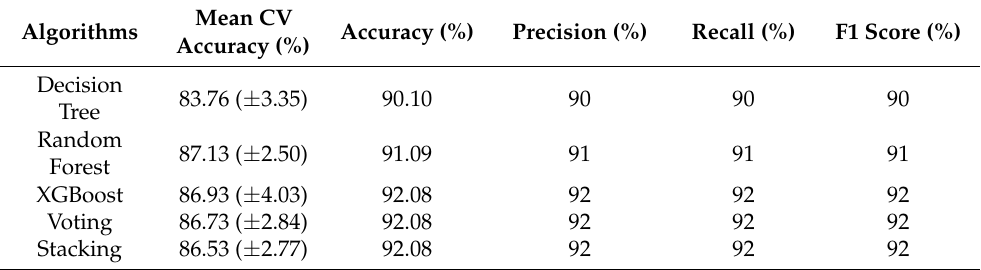
Table 3. Best performance of different machine learning algorithms on the